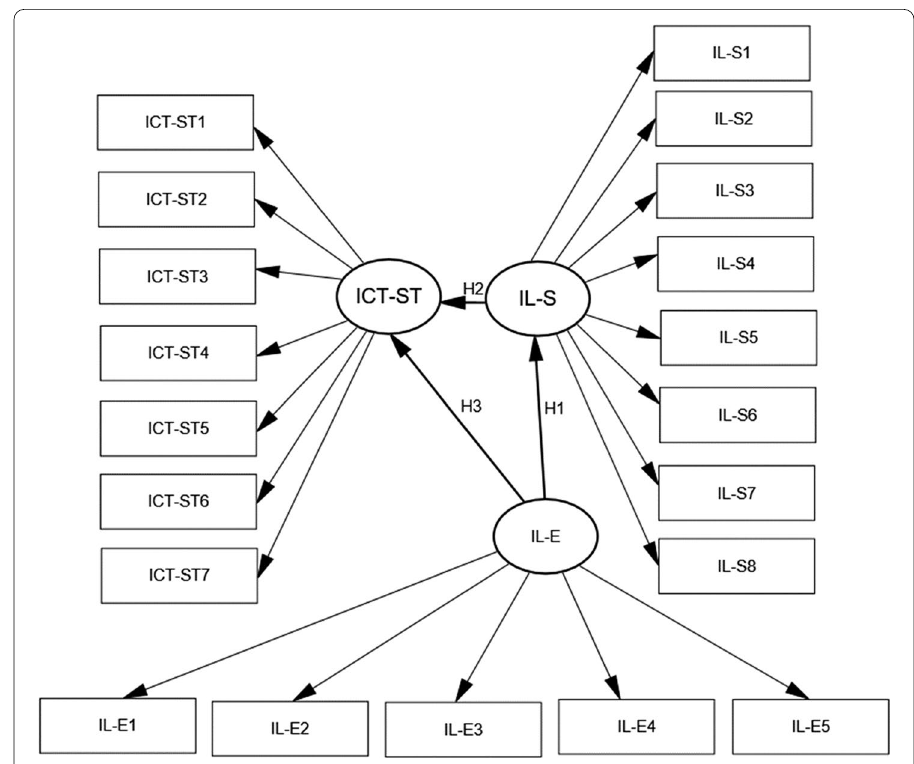
Fig. 1 Structural model for structural equation modeling (SEM). Unobserved variables: information evaluation literacy (IL-E), information search literacy (IL-S), and pre-service teachers’ ICT self-efficacy in